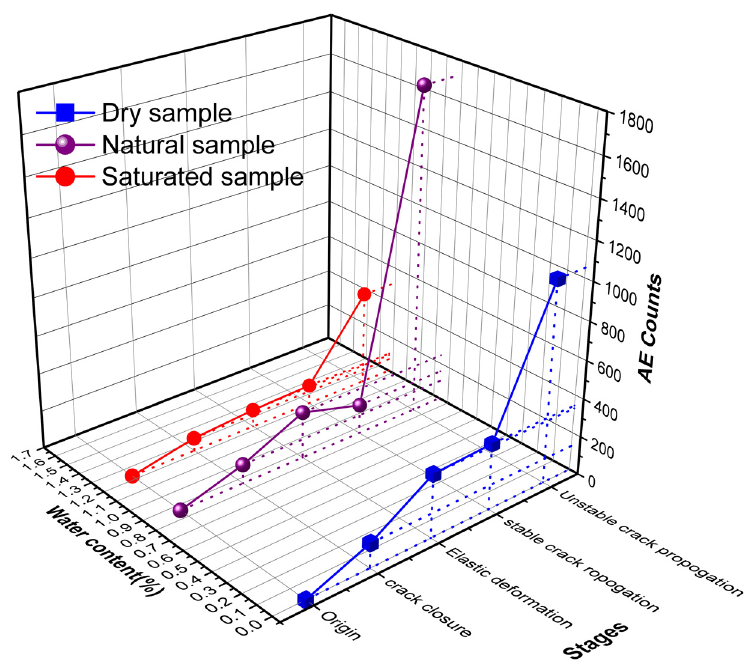
Figure 15. The effect of water on AE counts in different stages of dry, natural, and saturated coal sample.